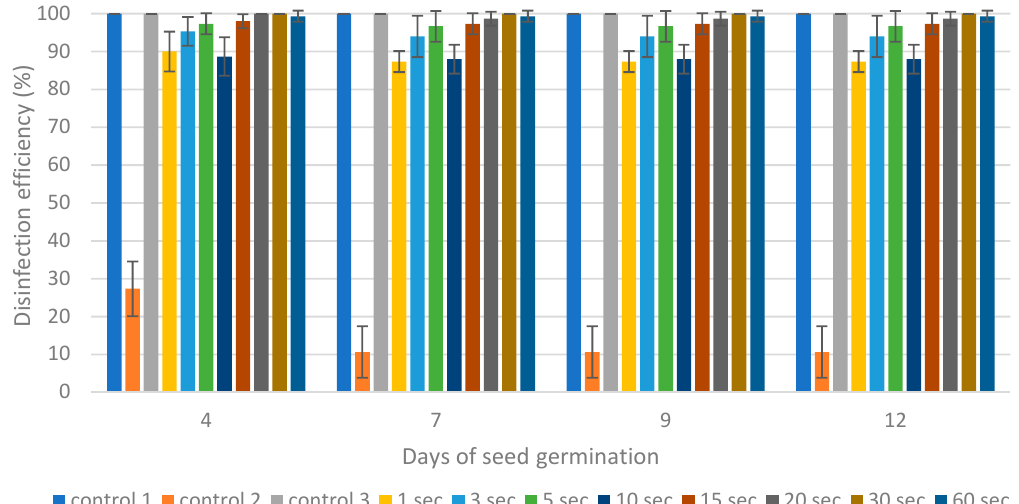
Figure 2. Disinfection efficiency (%) of Scots pine seeds inoculated with F. oxysporum exposed to different times of non-thermal plasma treatment after the 4 th , 7 th , 9 th , and 12 th days of fungal incubation. Control 1: seeds uninfected and non-treated with plasma; control 2: seeds infected with F. oxysporum and non-treated with plasma; control 3: seeds infected with F. oxysporum , non-treated with plasma, but sterilized with 30% perhydrol. More details are given in the Methods. Table 1. Effect of diffuse coplanar surface barrier discharge (DCSBD) plasma treatment on Scots pine seeds infected with F. oxysporum . Characteristics measured (mean and standard deviation (SD) are given) at the end of experimental cultivation (12 th day). Tukey’s HSD (Honest Significant Difference) test was used. Significant differences at p < 0.05 are indicated by different letters. Control 1, control 2, and control 3, see Figure 2. More details are given in the Methods.